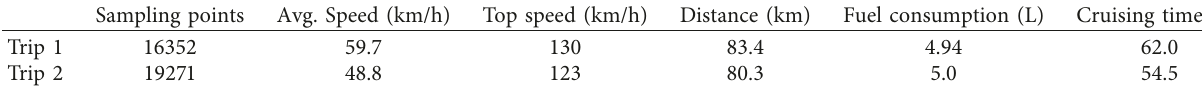
Table 1: Basic information for the selected round